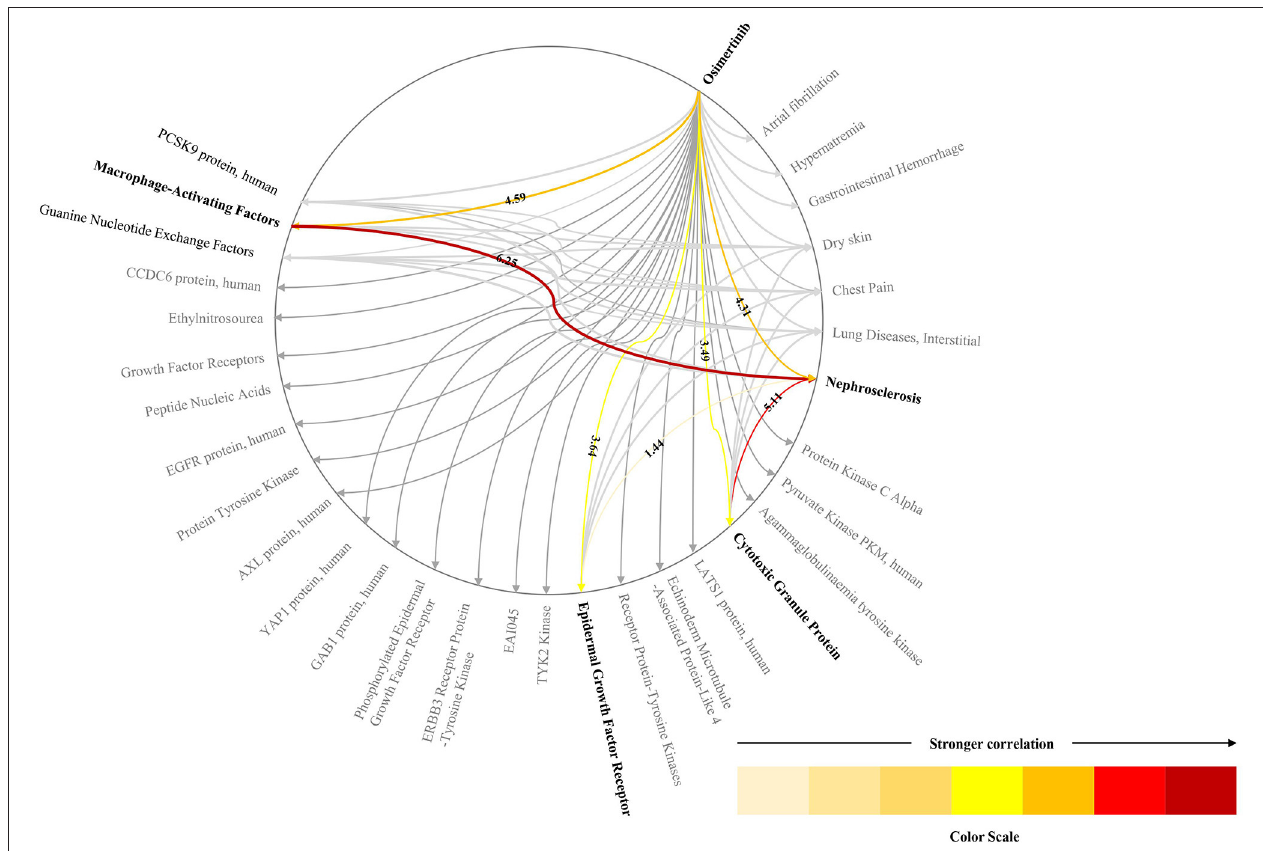
FIGURE 5 | The explainable pathway between osimertinib and one of its ADRs. This figure shows the pathways between osimerinib, top 1% related biomarkers and parts of ADRs. We only highlights the pathways between osimerinib, nephrosclerosis and three biomarkers: “Cytotoxic Granule Protein,” “Epidermal Growth Factor Receptor,” and “Macrophage-Activating